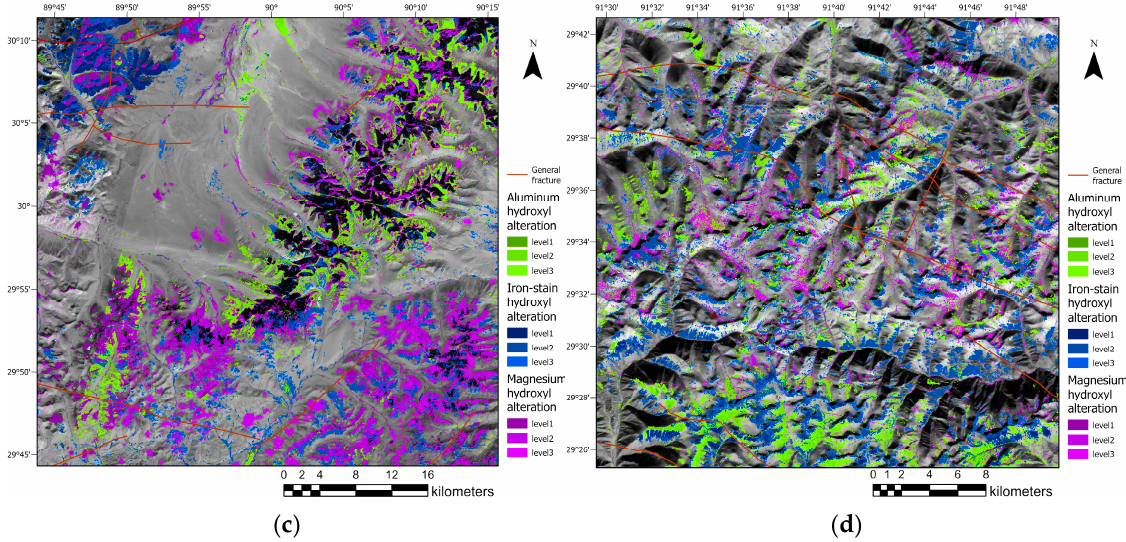
Figure 21. Multi-source geoscience element concentration area. ( a ) Neoproterozoic porphyry tectonic window in Saga County, Shigatse City, southwest of the study area; ( b ) Paleoproterozoic porphyry fracture zone in Xaitongmen County, Shigatse City, northwest of the study area; ( c ) Paleozoic and Paleocene granite porphyry fracture zone in the southern Tanggula Range, Nyingchi; ( d ) Paleozoic porphyry fracture zone in eastern Lhasa, central of the study area.